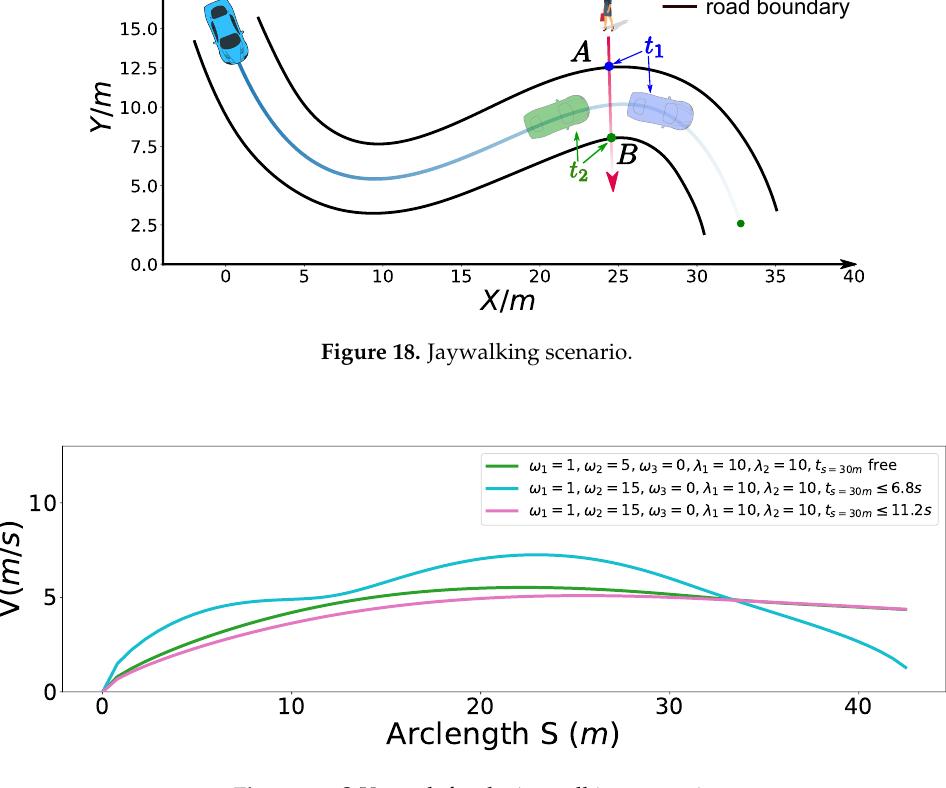
Figure 19. S-V graph for the jaywalking scenario.